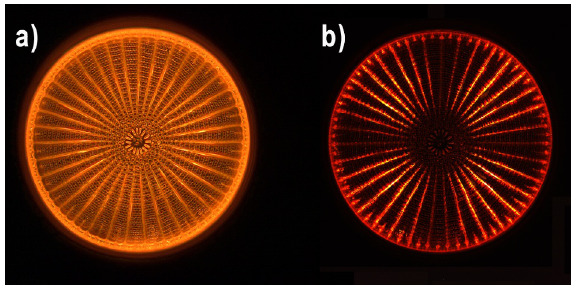
Figure 1. Dark field ( a ) and crossed-polarization dark field ( b ) images of a single valve of A. ehrenbergii diatom frustule. Di- ameter of the valve (cid:39) 270 µ m.